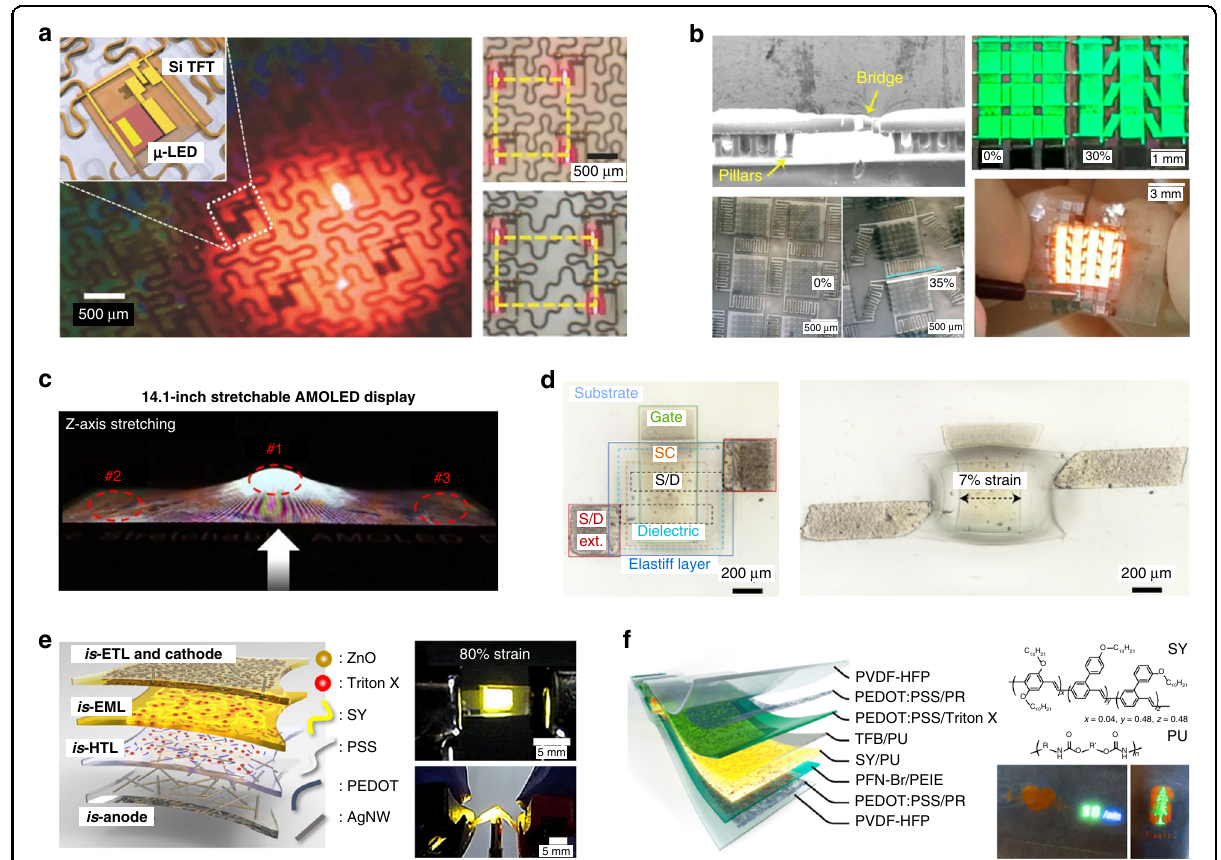
Fig. 6 Basic technologies in the 3D free-form stretchable displays. a Serpentine-shaped interconnections and integrated µLEDs driven by Si- based TFTs. Reproduced with permission from ref. 47 Copyright 2017 Wiley-VCH. b Stretchable OLED display deposited on a patterned substrate with a stress-relief elastic pillar array and interconnection bridges. Reproduced with permission from ref. 48 Copyright 2020 American Chemical Society. c 14.1-inch stretchable active-matrix OLED display with wave-shaped interconnecting hinges. Reproduced with permission from ref. 49 Copyright 2019 Wiley-VCH. d Intrinsically stretchable transistor array integrated on a patterned elastomer layer with tunable stiffness. Reproduced with permission from ref. 50 Copyright 2021 Springer Nature. e Stretchable OLED composed of intrinsically stretchable ( is -) layers. Reproduced with permission from ref. 51 Copyright 2021 AAAS. f Structure and light-emitting polymers of the on-skin stretchable all-polymer LED (APLED) displaying pulse signals in real-time. Reproduced with permission from ref. 52 Copyright 2022 Springer